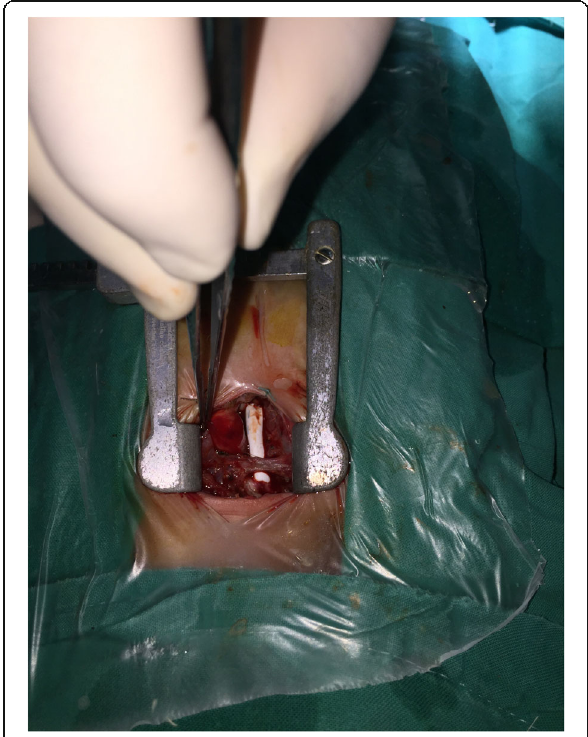
Fig. 3 Operative view of the MBT shunt constructed via upper ministernotomy in a neonate patient